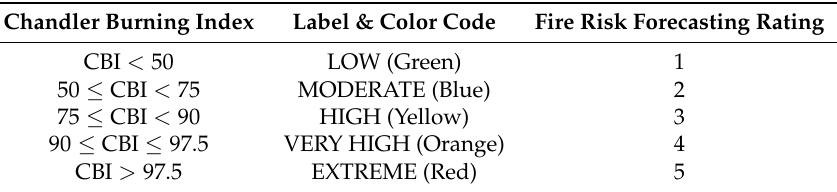
Table 3. F.E.MO.S. fire risk forecaster scale